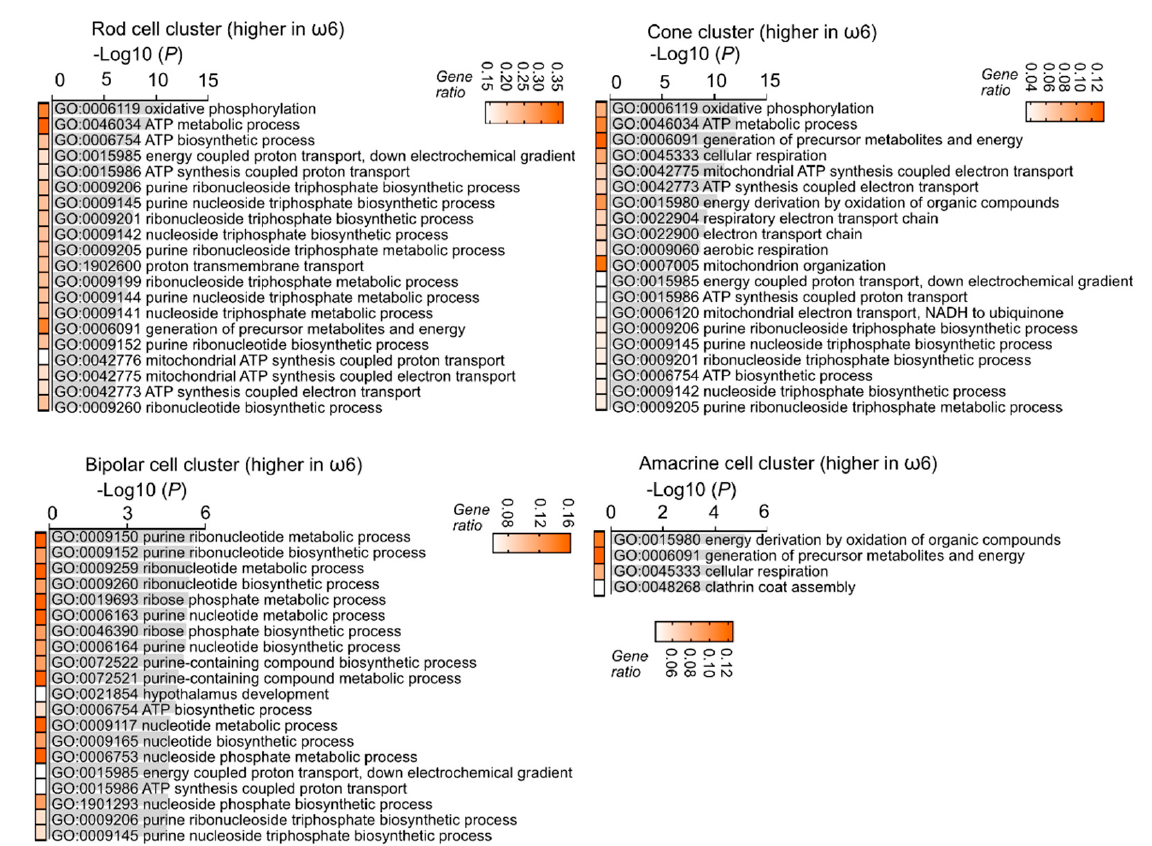
Figure 5. ω -6 vs. ω -3 increased retinal neuronal metabolism identified with single-cell analysis. The higher expression of genes (top 20) in the rod and cone cluster of ω -6 vs ω -3 diet-fed Phase I ROP mice were associated with energy production related gene ontology terms. The higher expression of genes in the bipolar cell cluster of ω -6 versus ω -3 LCPUFA-fed Phase I ROP mice were associated with purine ribonucleotide (components of DNA, RNA, adenosine triphosphate (ATP), guanosine triphosphate (GTP), cyclic adenosine monophosphate (cAMP), nicotinamide adenine dinucleotide (NADH), and coenzyme A) metabolic and biosynthetic process related gene ontology terms. The higher expression of genes in the amacrine cell cluster of ω -6 versus ω -3 LCPUFA-fed Phase I ROP mice were associated with energy production related gene ontology terms. Adjusted p -values for enriched gene ontology (GO) terms are shown in bar graphs ( p < 0.05). Gene ratio for each pathway is shown in